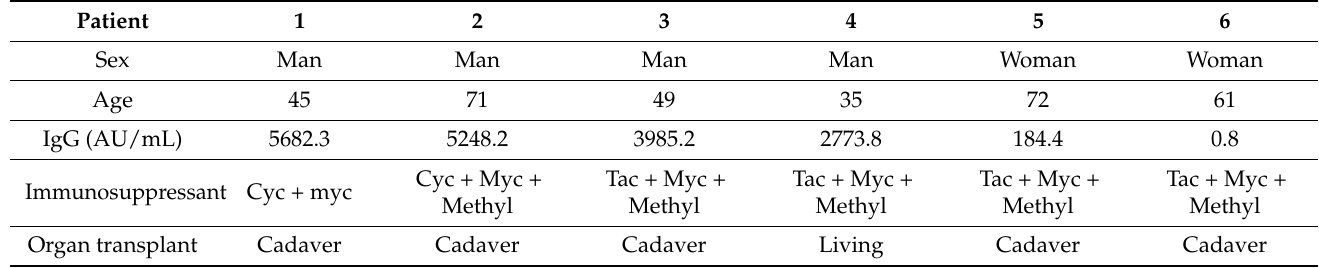
Table 4. The demographics of the enrolled patients who developed COVID-19 after the end of the study. Cyc: cyclosporine; Myc: mycophenolate; Methyl: methylprednisolone; Tac: tacrolimus. IgG levels represent the last value recorded before the SARS-CoV-2